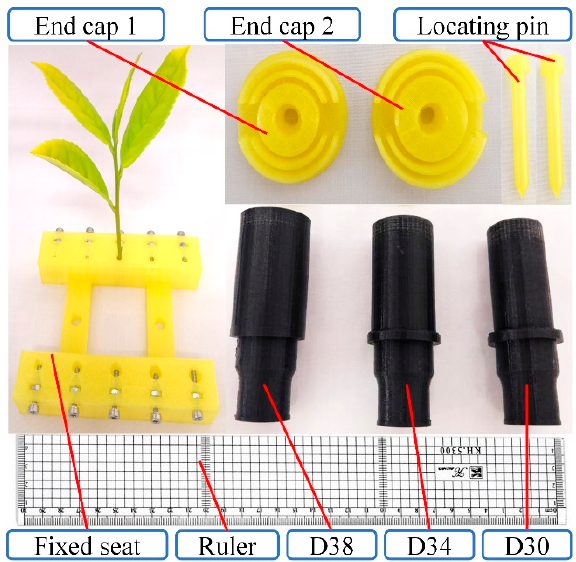
Figure 11. Experimental supplies.